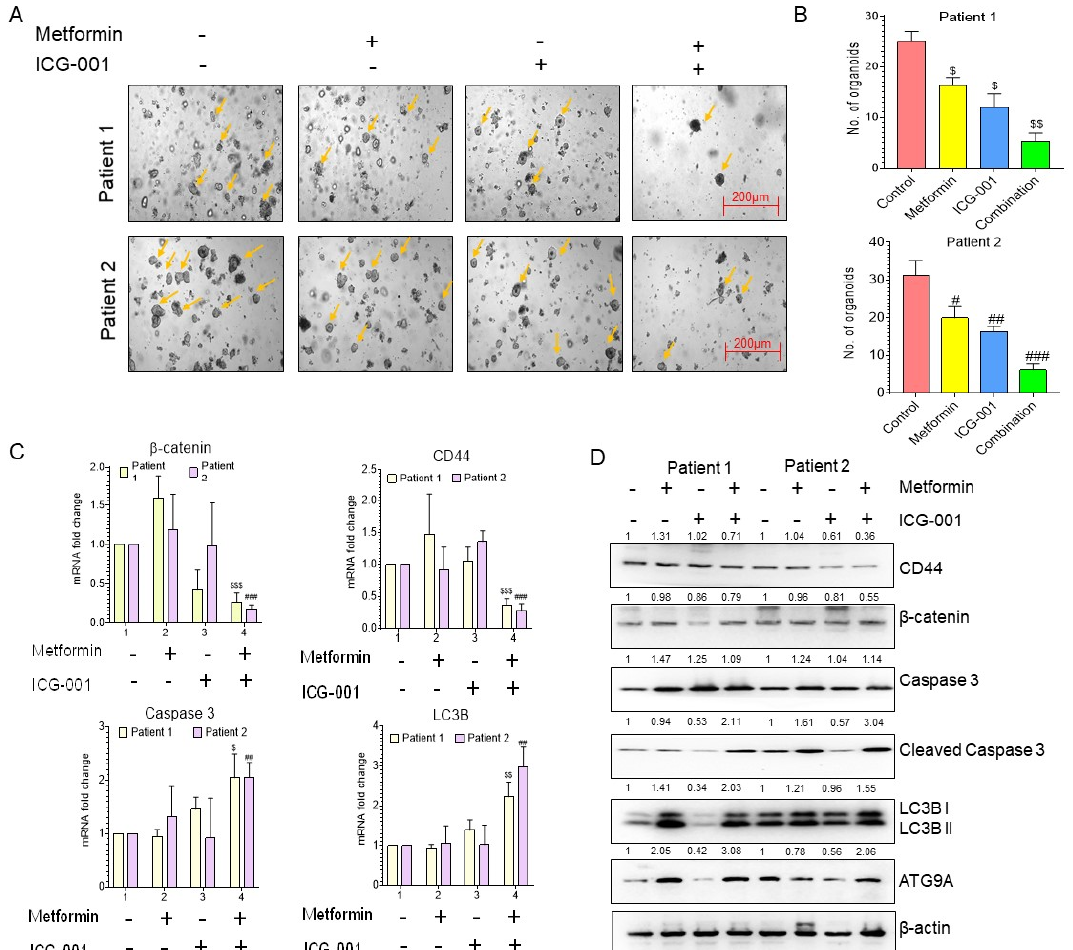
Figure 6. The anti-tumor activity of metformin and ICG-001 in a CRC patient-derived organoid model. ( A ) Representative images of patient-derived tumor organoids. ( B ) Number of organoids formed after treatment with metformin and ICG-001, either alone or in combination. ( C ) Gene ex- pression analysis of β -catenin, CSC marker (CD44), apoptosis marker (caspase 3) and autophagy marker (LC3B) in patient-derived tumor organoid after treatment with metformin and ICG-001, ei- ther alone or in combination, for 10 days. β -actin was used as a housekeeping gene. ( D ) WB analysis of β -catenin, CSC marker (CD44), apoptosis markers (caspase 3 and cleaved caspase 3), and autoph- agy markers (LC3B, ATG9A) from the protein lysate extracted from patient-derived organoids after treatment with metformin and ICG-001, either alone or in combination. β -actin was used as loading control for WB analysis. Original blots see File S1. Statistical significance was determined by a Stu- dent’s t -test. (Comparison between Control vs. treatment groups for Patient 1- $ p < 0.05, $$ p < 0.01, and $$$ p < 0.001; comparison between Control vs. treatment groups for Patient 2- # p < 0.05, ## p < 0.01, and ### p < 0.001.) 4. Discussion Considerable advancements and improvements in treatment modalities for CRC has led to increased overall survival among CRC patients in the past decade [42]. Since 1990, 5FU-based chemotherapy has been the backbone of the CRC treatment regimen [43]. A thymidylate synthase inhibitor, 5FU exerts its anti-tumor efficacy by increasing DNA damage, thereby causing cell cycle arrest and apoptosis [44,45]. Despite its routine use, the beneficial role of 5FU is somewhat limited as its treatment is often associated with